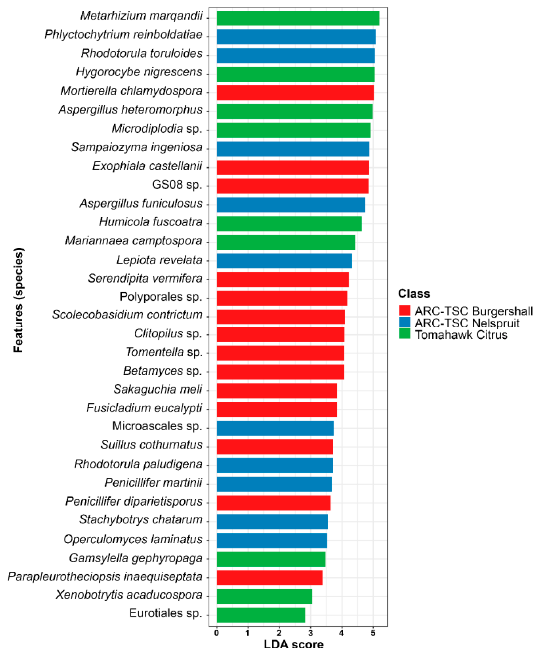
Figure 9. Hierarchical clustering illustrated by means of a heatmap and dendrogram for the 20 most abundant fungal taxa associated with the rhizospheres of 14 orchards sampled in Mpumalanga province, South Africa.